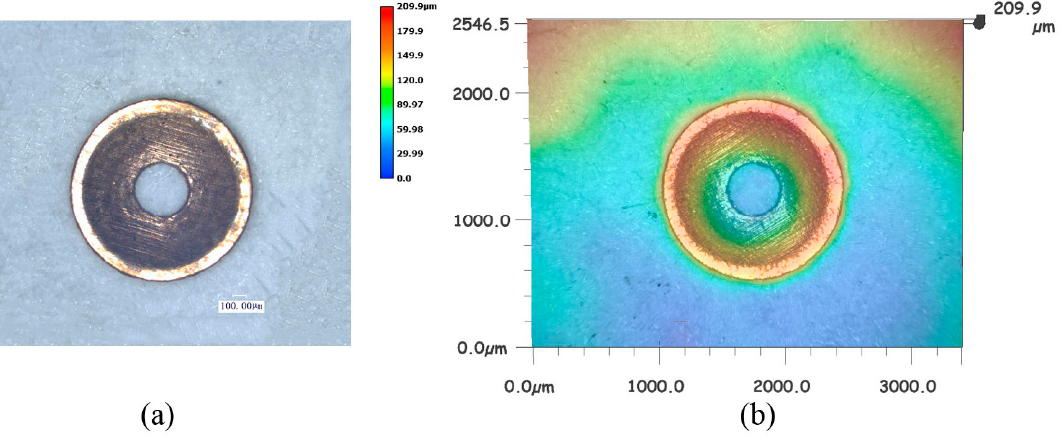
Figure 5. The morphology of a micro-part when a laser energy of 1550 mJ was employed on the work piece: ( a ) 2D plot of the dish-shaped micro-part; ( b ) 3D plot of the dish-shaped micro-part.